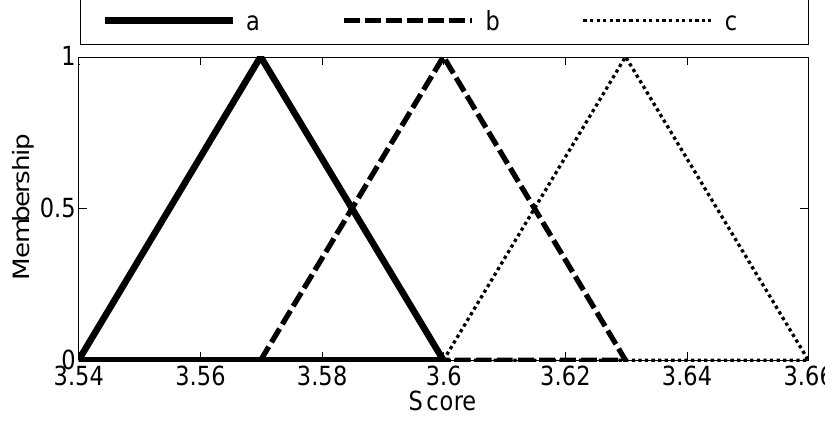
Fig. 2. Input membership functions for K 1